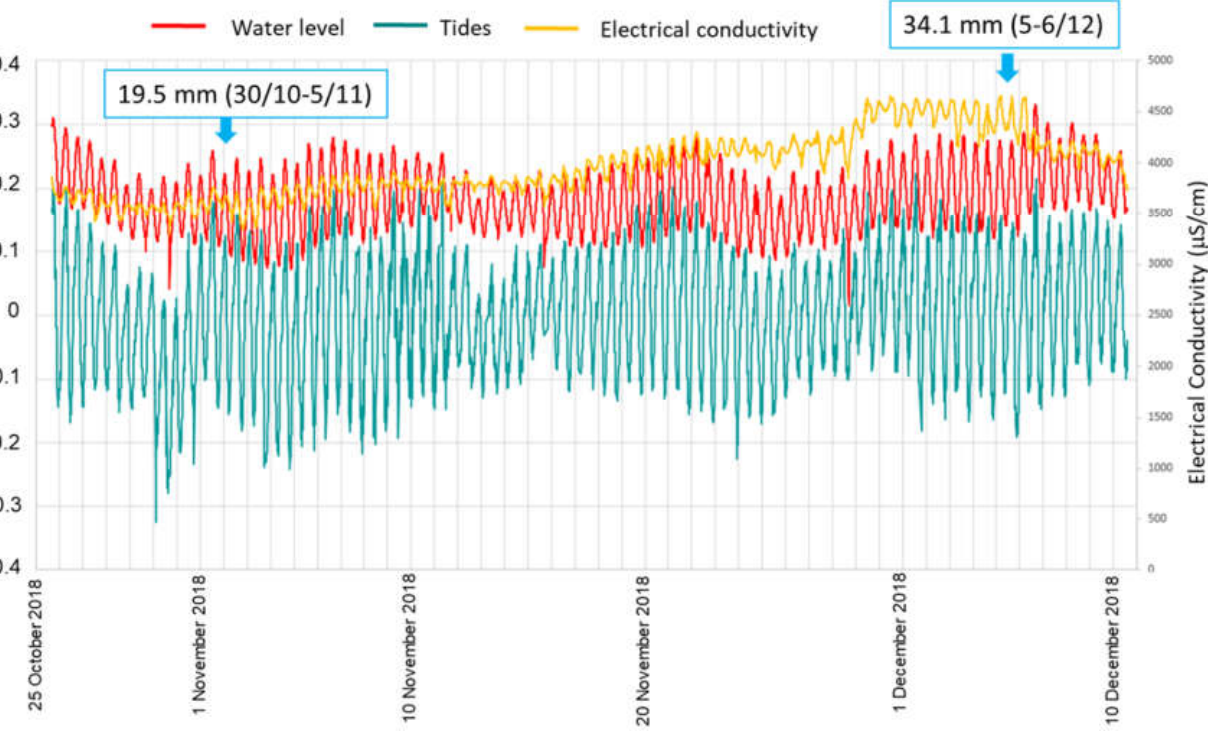
Table 1. Characteristics of the pumping tests and obtained transmissivity.